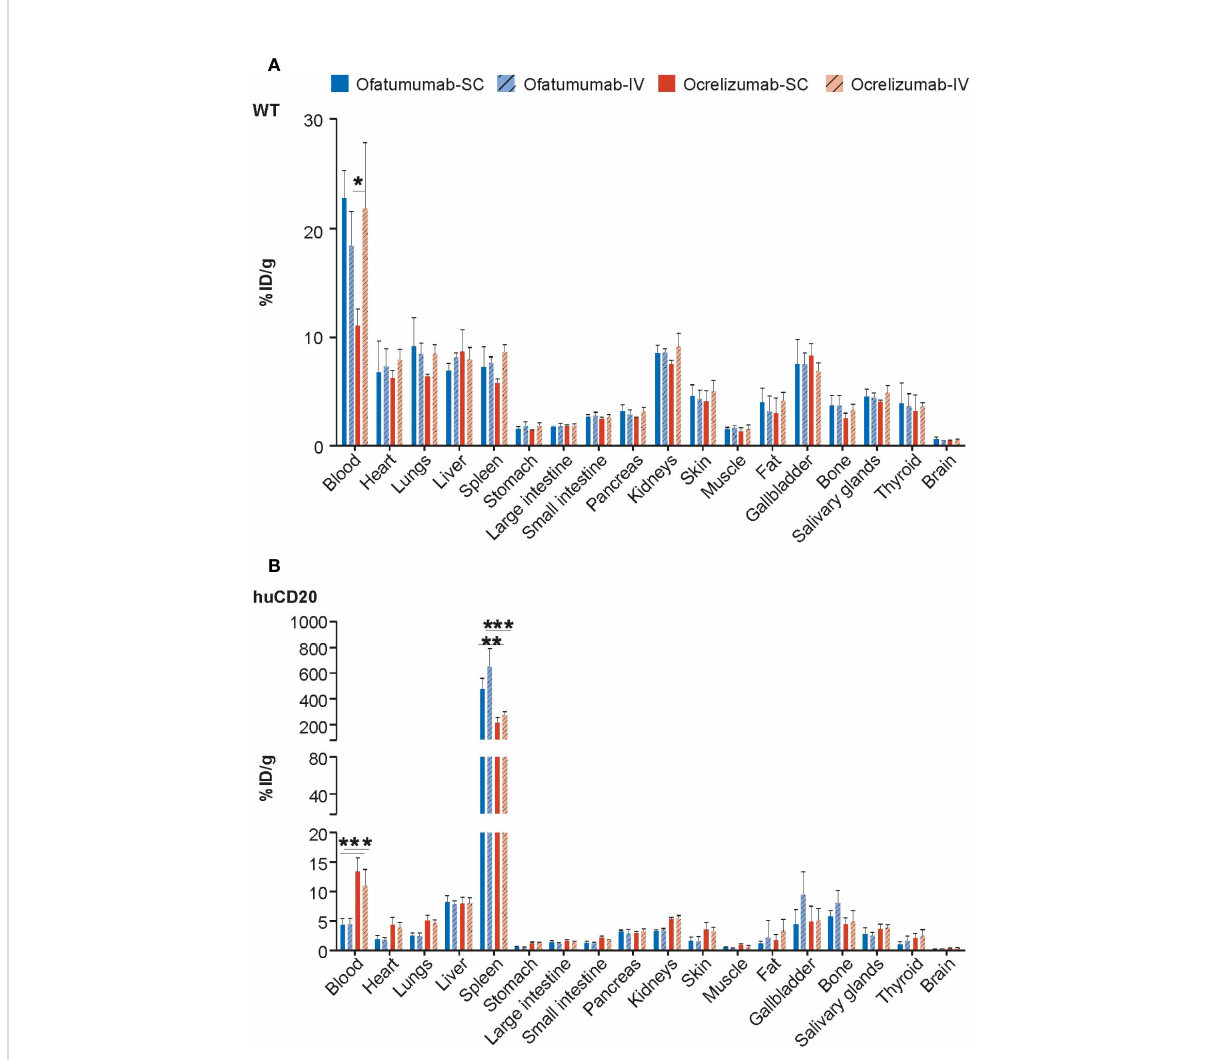
FIGURE 2 Gamma counting analysis of 111 In-ofatumumab and 111 In-ocrelizumab in the blood and individual organs of WT and huCD20 mice. (A) Non- speci fi c accumulation of 111 In-ofatumumab and 111 In-ocrelizumab was observed in the tissue of WT mice. (B) Increased levels of 111 In- ocrelizumab and 111 In-ofatumumab were observed in the B-cell rich spleen of huCD20 mice. 111 In-ofatumumab-treated huCD20 mice displayed faster clearance from the blood and uptake in the spleen following both SC and IV administration compared with 111 In-ocrelizumab. * p < 0.05; ** p < 0.01; *** p < 0.001. Data represent mean ±